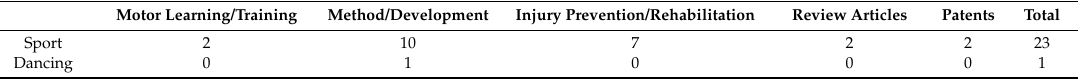
Table 2. The article types of real-time biomechanical feedback training found in Web of